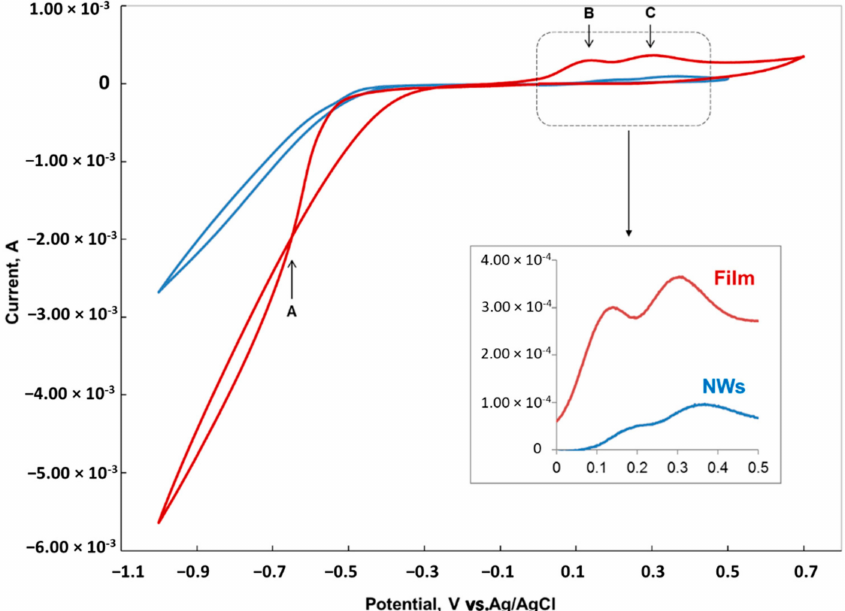
Figure 2. Cyclic voltammetry of Au in the Co-Ni solution at 20 mV / s sweep rate (red and blue lines are the scans for film and NW configuration electrodes, respectively). The inlet shows a magnified portion of the cyclic voltammetry (CV) in the potential range from 0 to 0.5